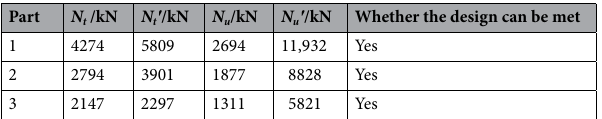
Table 2. Tower calibration.